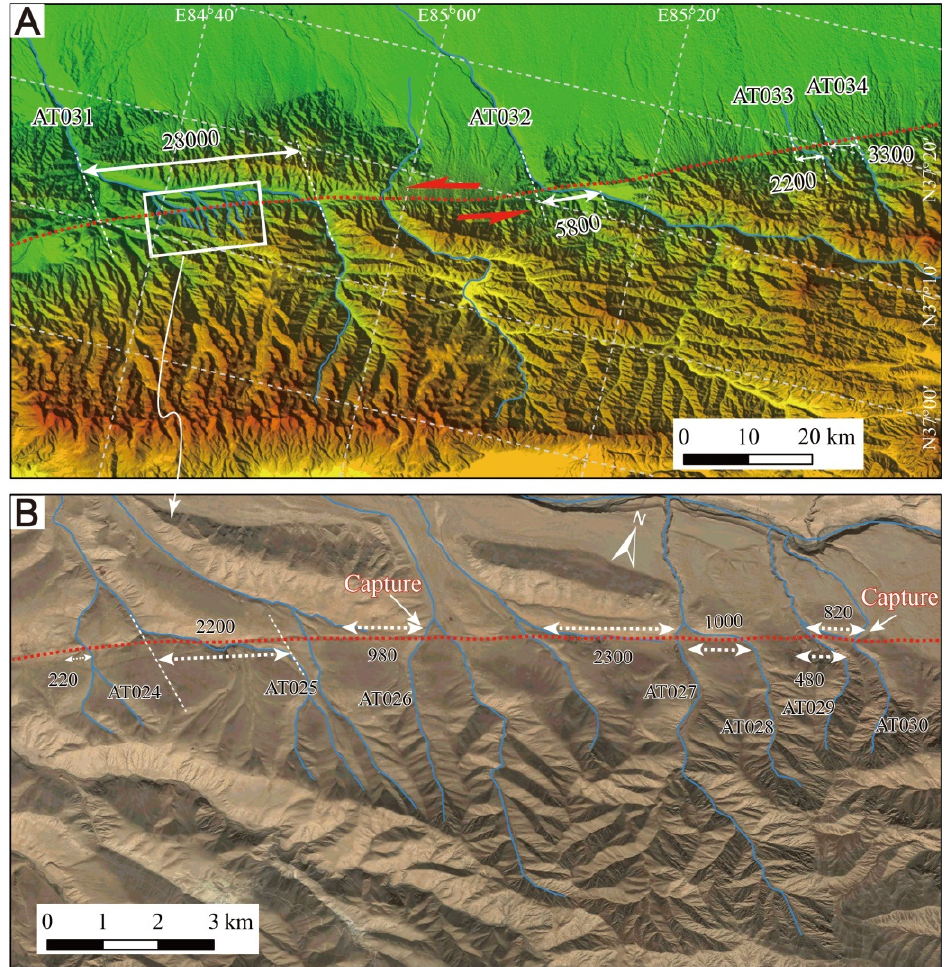
Figure 3. ( A ) SRTM 90 m resolution color-shaded relief map showing the topography features and offset large river channels (see Figure 1B for location, Table S1 for measurement uncertainty). ( B ) High-resolution Google Earth images showing the offset of small rivers (AT024–AT030) with a short upstream length. Red dotted line indicates the active fault trace. All the offsets are in meters.